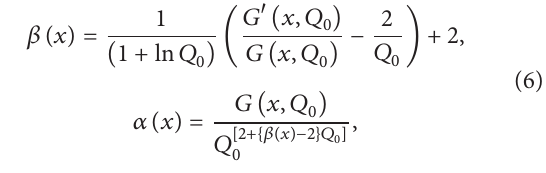
Figure 2: The subprocess Feynman diagram for dilepton produc-